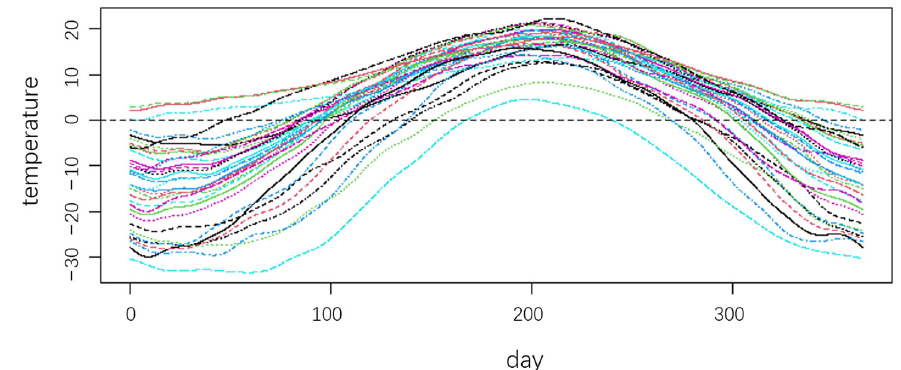
Figure 2. Temperature data for 35 sites (one color stands for one site).